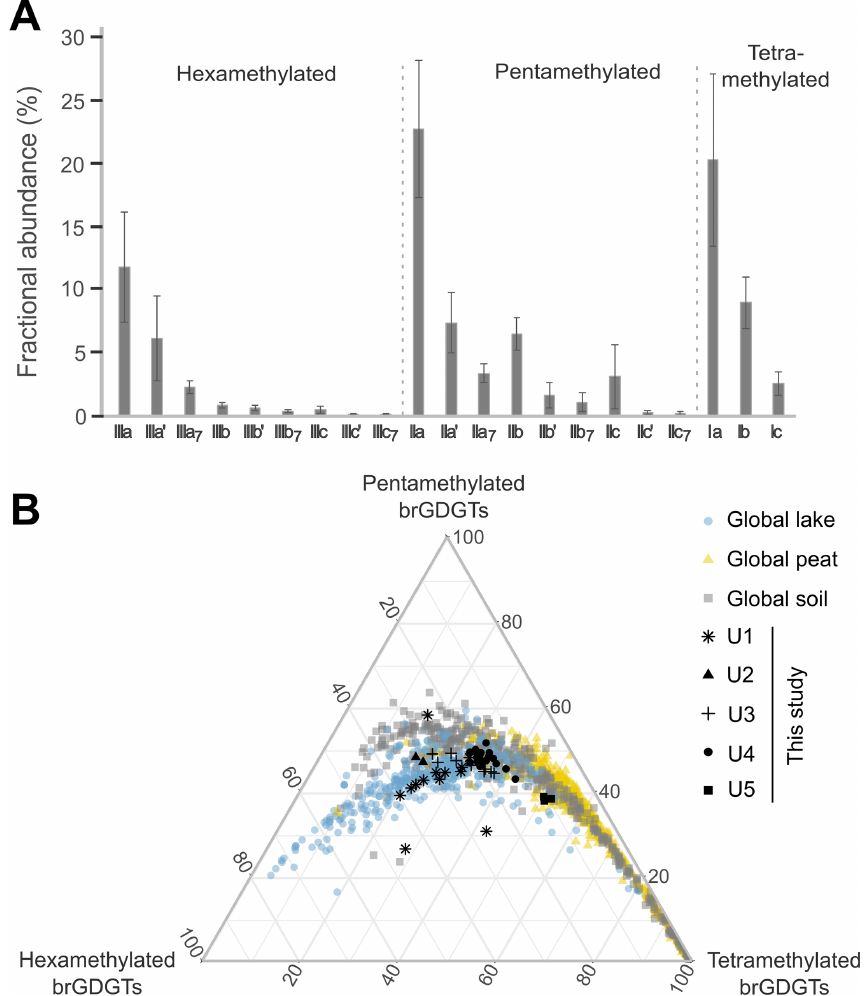
Figure 6. (a) Fractional abundances of tetra-, penta- and hexa-methylated brGDGTs for the Matese core. (b) Ternary diagram showing the fractional abundances of the tetra-, penta- and hexa-methylated brGDGTs for the Matese core (black points) and global lakes (blue points; Martínez-Sosa et al., 2021), peats (yellow circles; Naafs et al., 2017a) and soils (gray circles; Yang et al., 2014; Naafs et al., 2017b).